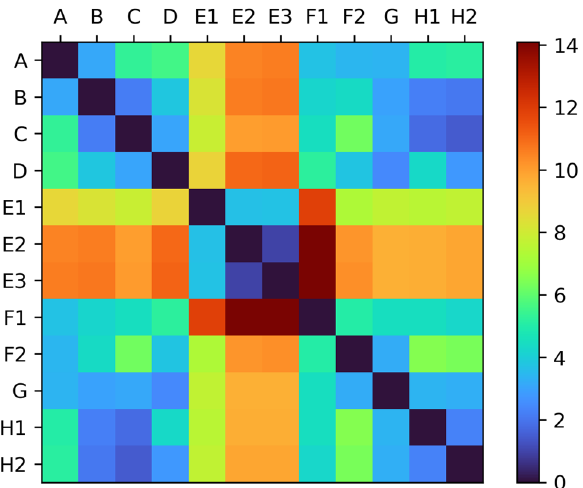
Figure 11. Heatmap plot for discrete Fréchet distance route similarity results (NM). Lower value and darker color intensity indicates higher similarity.